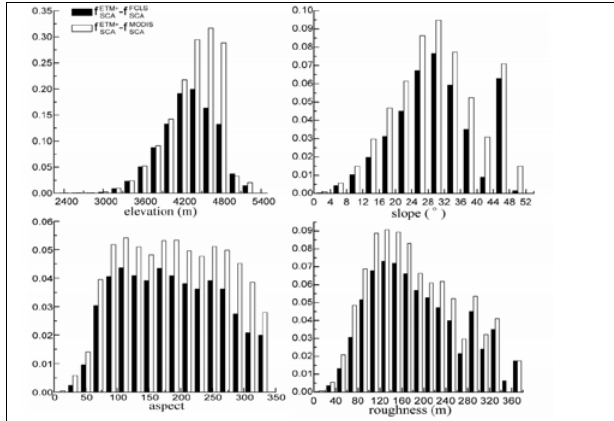
Figure 2. Impact of terrain characteristics on the accuracy of fractional snow-cover identification for all the MOD10A1 and FCLS snow